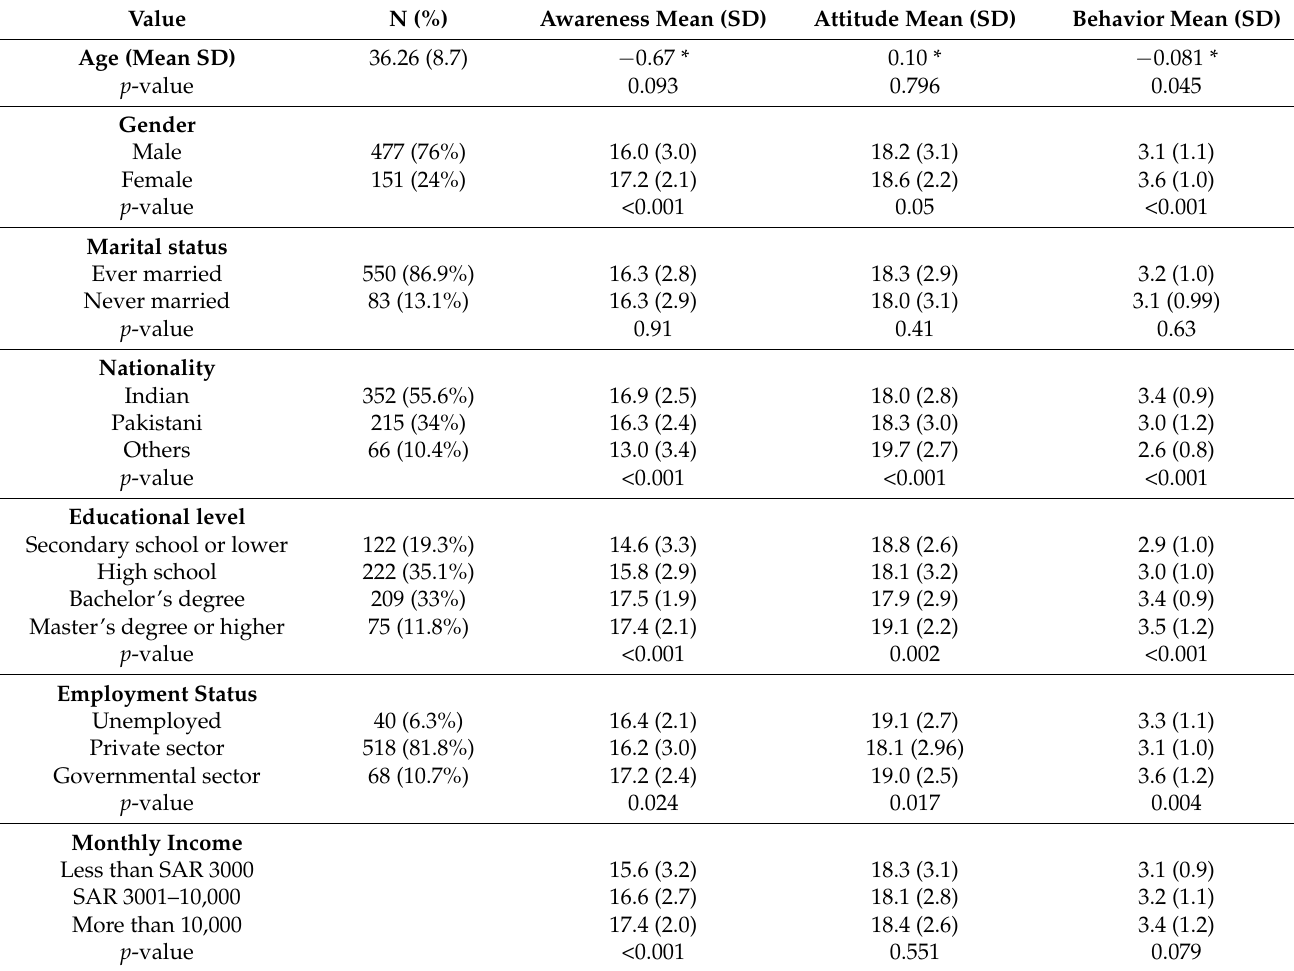
Table 1. Socio-demographic characteristics and COVID-19-related awareness, attitude, and behaviors of travelers arriving in KSA ( n =